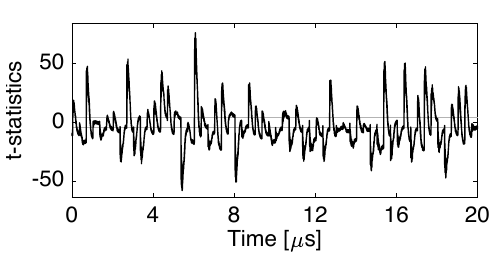
Figure 10: Experimental analysis (1st-order t-test) of our masked Skinny while both PRNG and initial sharing are off using 100 thousand traces, confirming the ability of our setup to detect 1st-order leakages.